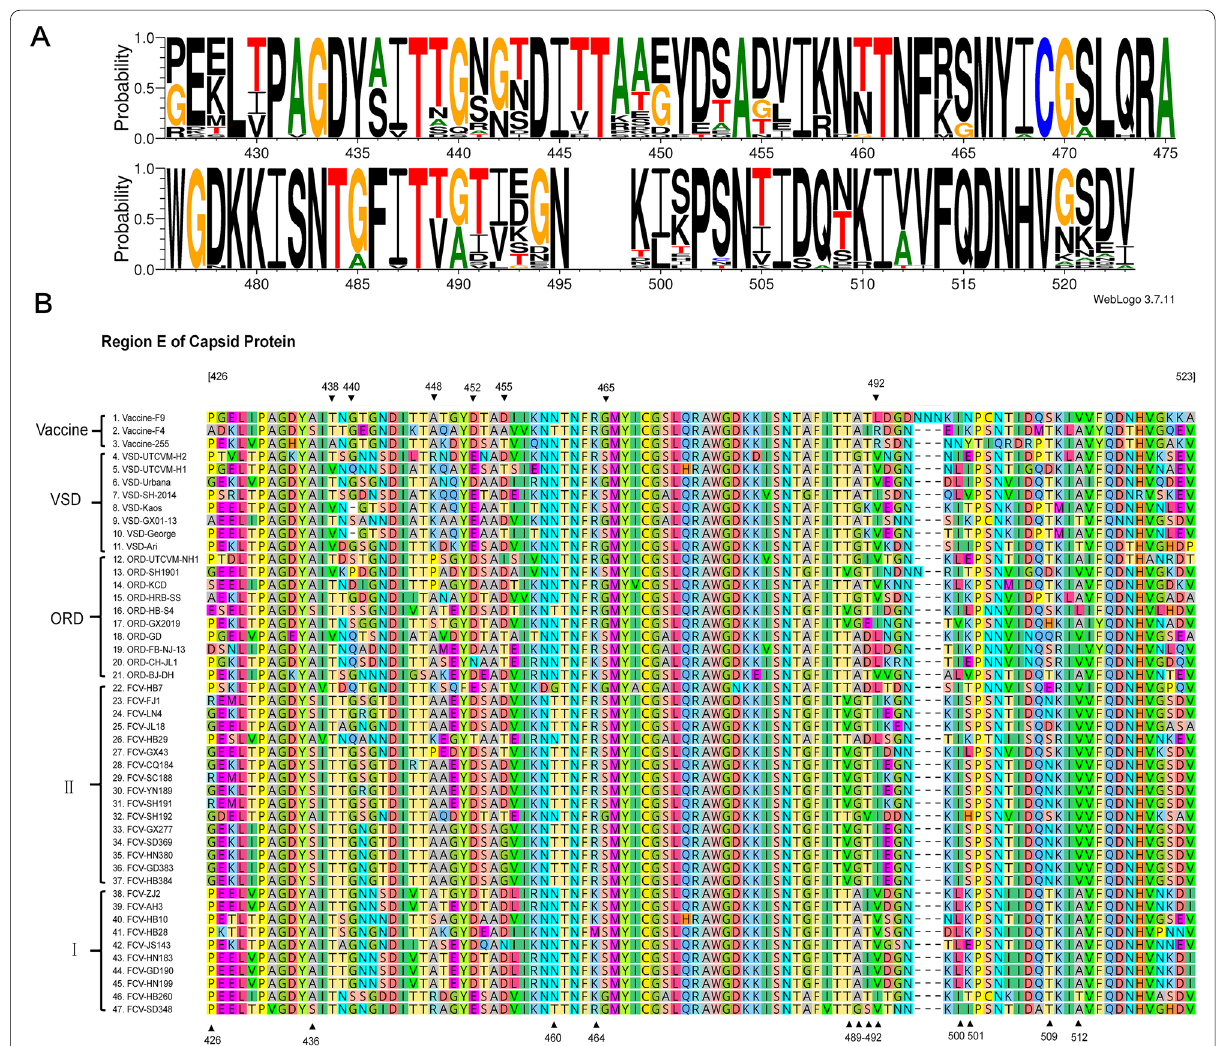
Fig. 3 Comparison of amino acids of capsid protein E region of the 26 FCV isolates. A Diversified mutations in the E region of capsid protein, the size of the graphic character at corresponding site is proportional to the occurrence frequency of amino acids at a certain site. B Specific identification sites of different genotypes are marked with black triangles at the bottom ( ▲ ), seven virulence factor-related sites are indicated by black triangles at the top ( ▼ ), “-” indicates missing